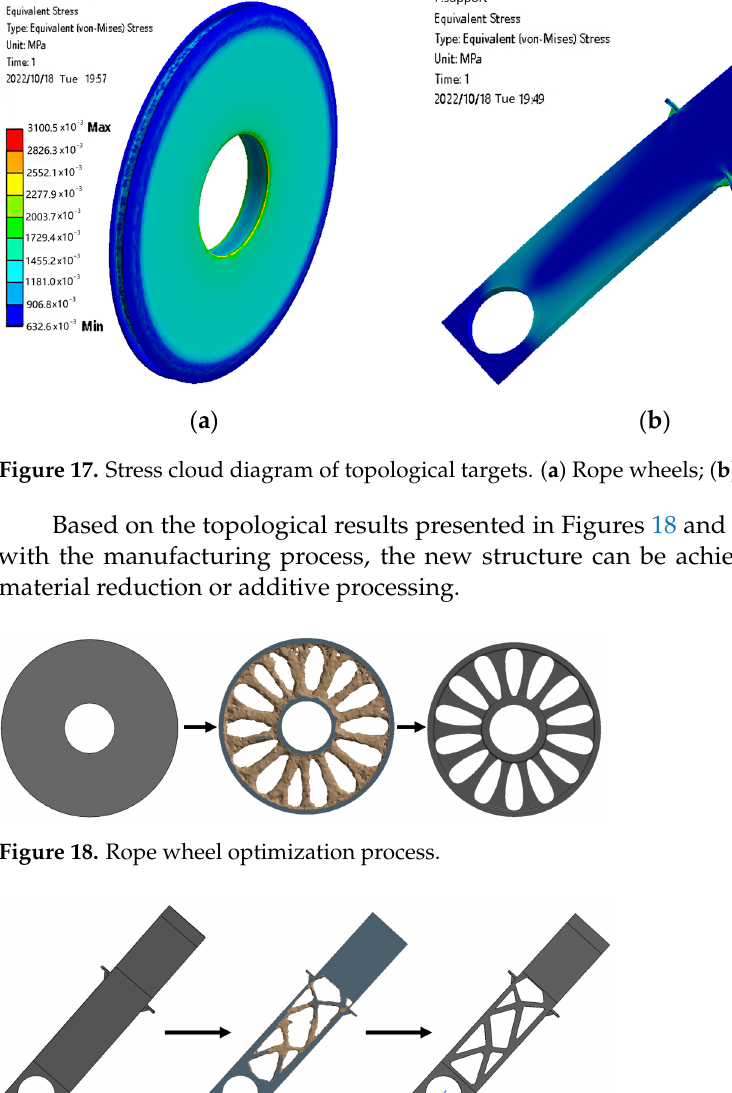
Figure 19. Optimization process of counterweight support.